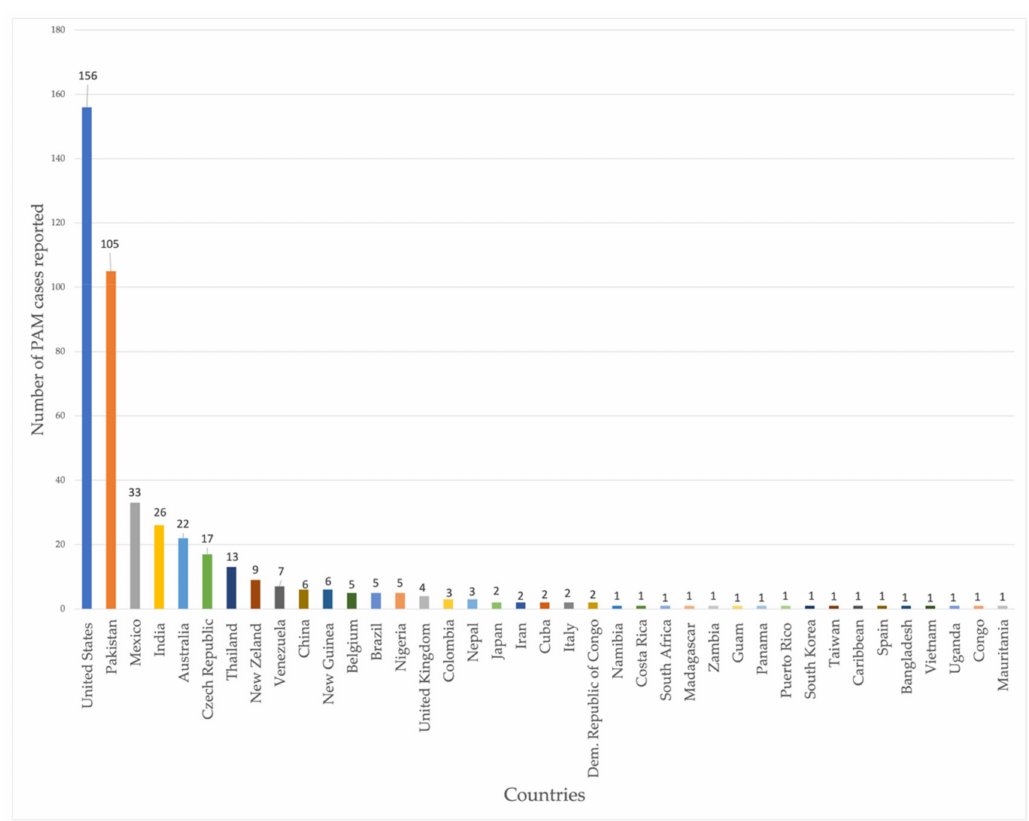
Figure 1. Worldwide documented cases of N. fowleri infections until 2018. Adapted from